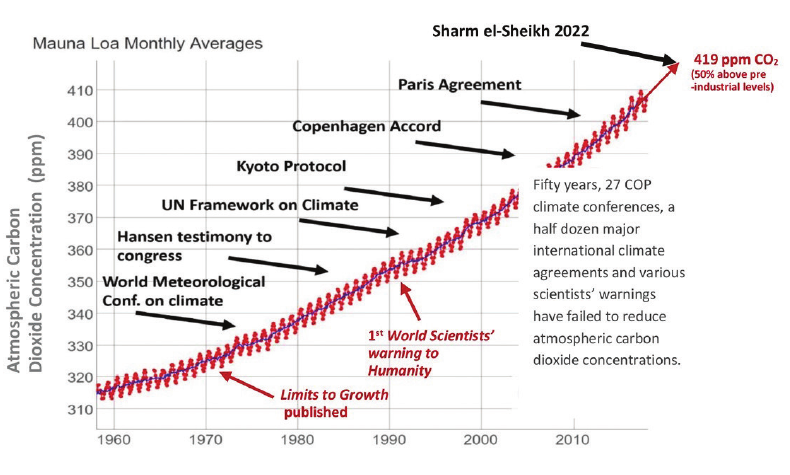
SOURCE OF CO2 DATA: NOAA